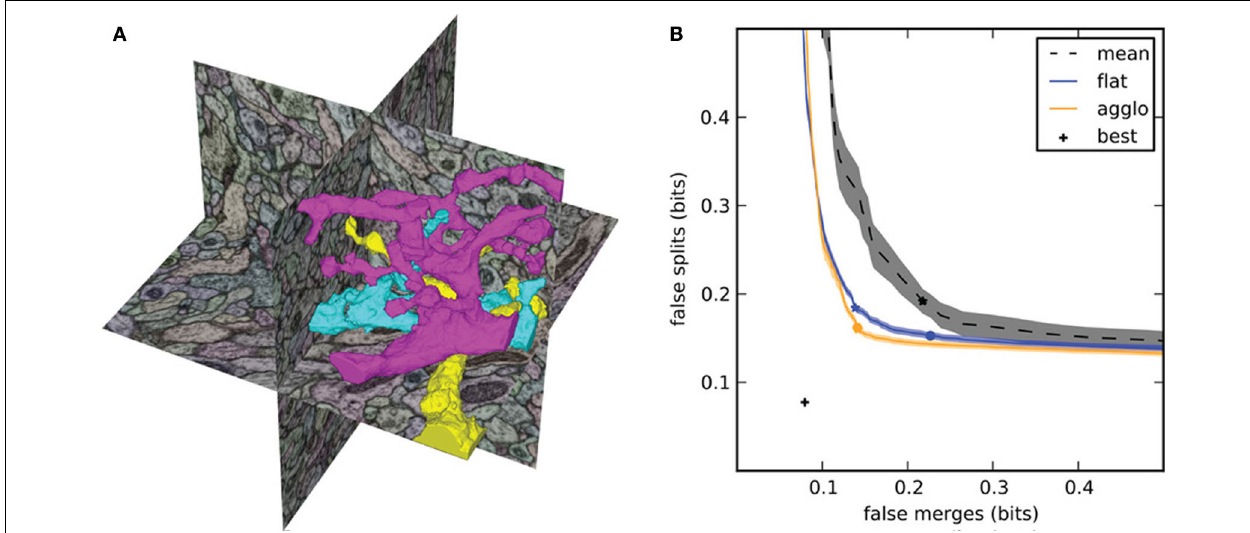
FIGURE 2 | Segmentation results for the focused ion beam scanning electron microscopy (FIBSEM) dataset of Drosophila melanogaster larva brain in Nunez-Iglesias et al. (2013). (A) Example automatic segmentation of an octant of the dataset. The complex shapes of the three highlighted segments illustrate the difficulty of segmenting neuronal data. (B) Split VI plot from Nunez-Iglesias et al. (2013), showing superior segmentation